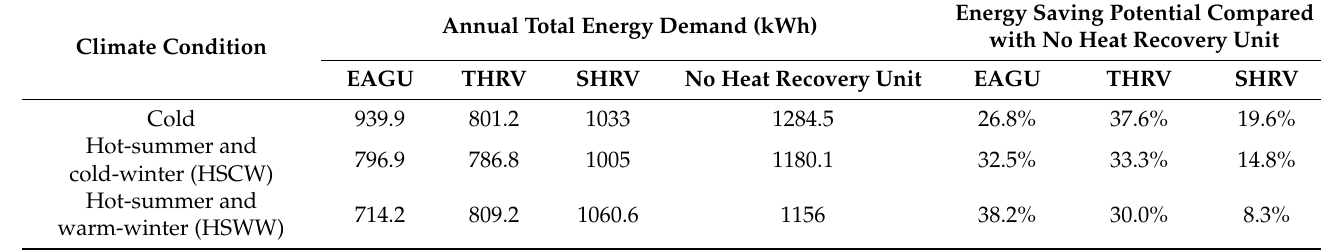
Table 4. Annual total energy demand of the four cases in different climate conditions.